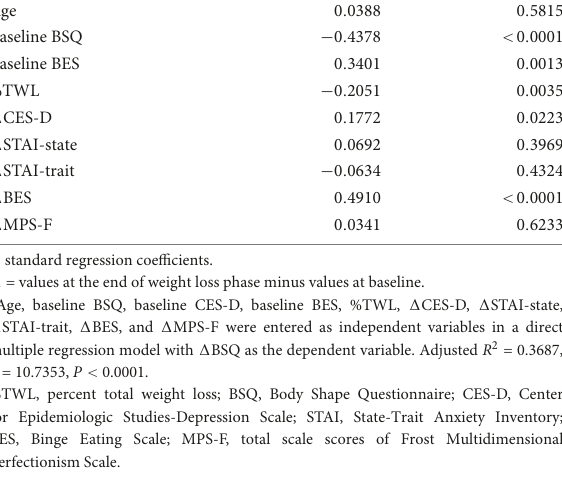
TABLE 4 Multiple regression analysis of (cid:49) BSQ and clinical variables. Independent